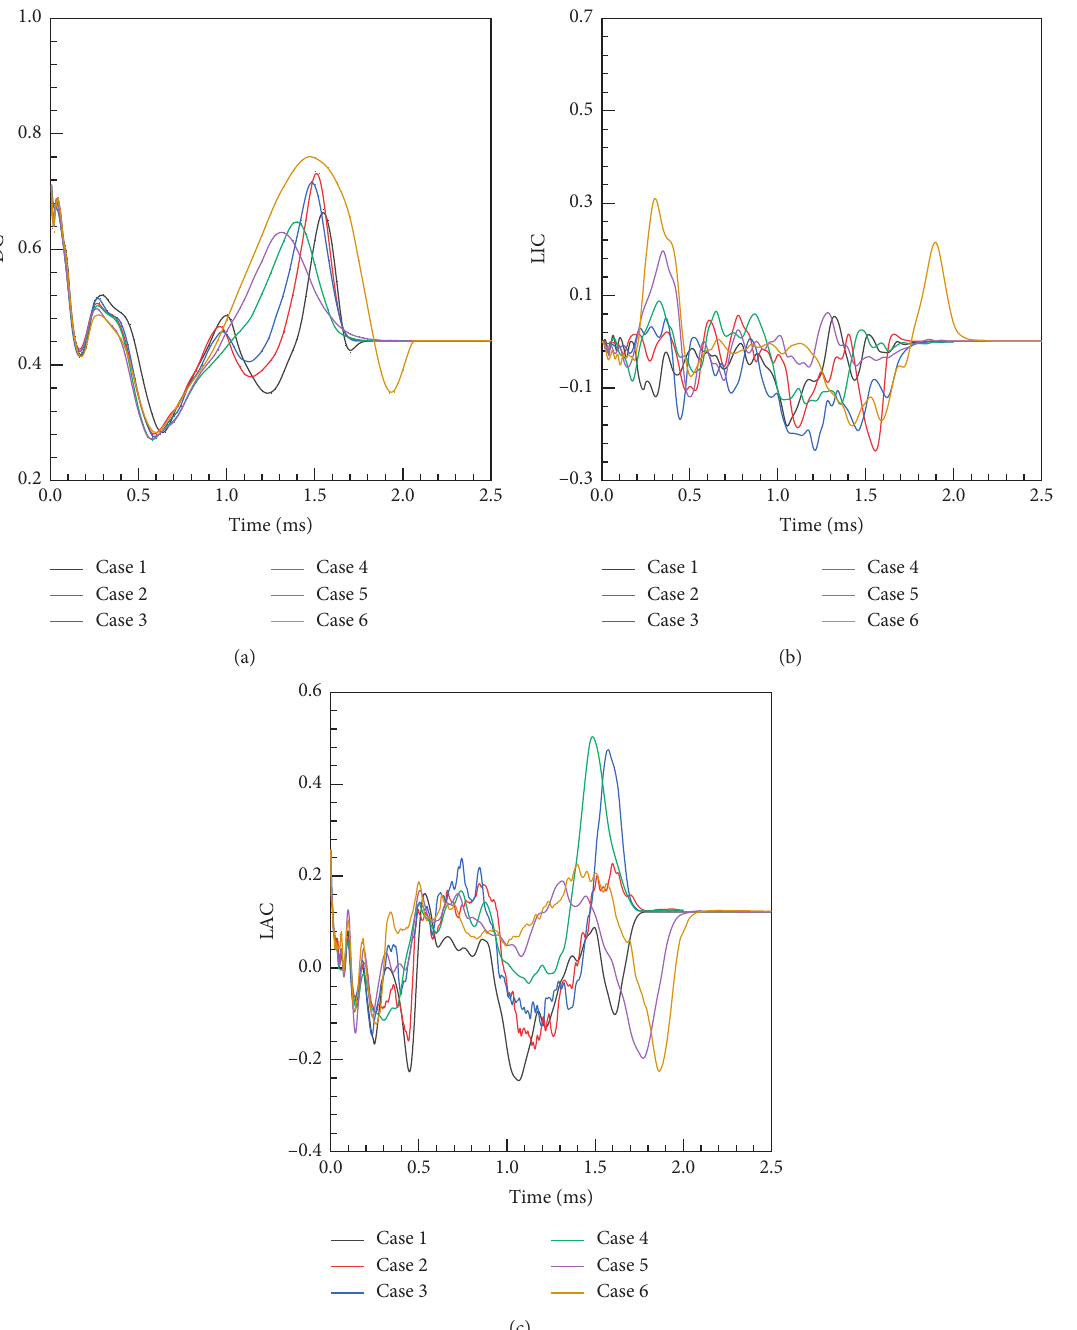
Figure 14: Force coefficient: (a) DC, (b) LIC, and (c)